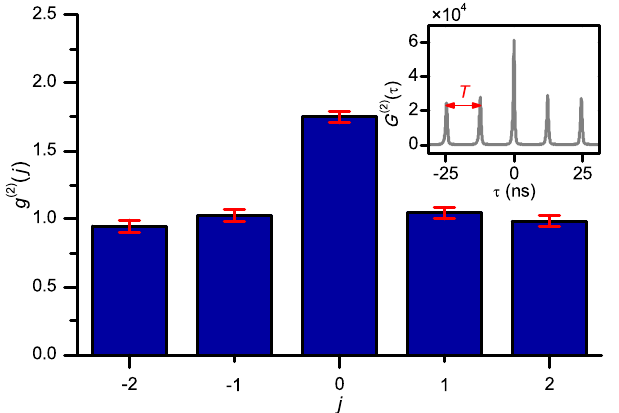
FIG. 4. Value of g ð 2 Þ across sequence of five pulses. At the bistable threshold the value of g ð 2 Þ ð 0 Þ shows a bunched value of 1.75 [see Fig. 5(a)]. The corresponding raw data consist of photon coincidences at the Hanbury Brown-Twiss photodetectors and is shown in the inset.